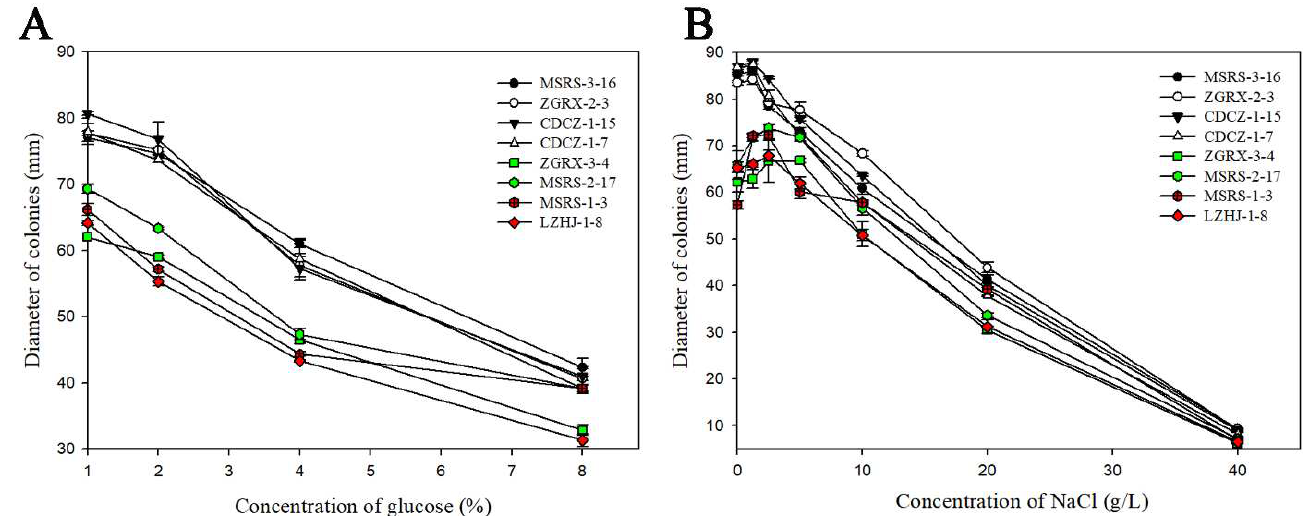
Figure 2. Fitness determination of tebuconazole-susceptible and -resistant isolates on PDA medium with different concentrations of glucose ( A ) or NaCl ( B ). Red or green indicates high or medium resistance to tebuconazole, respectively; black or white indicates tebuconazole-susceptible isolates. The F 7,23 values of the colony diameters of the different isolates on the PDA with 1% glucose, 2% glucose, 4% glucose, and 8% glucose were 114.368, 11.767, 1.072, and 32.483; the p values were = 0.000 < 0.0001, = 0.000 < 0.01, = 0.426 > 0.05, and = 0.000 < 0.01, respectively. The F 7,23 values of the colony diameters of the different isolates on the PDA with 0, 1.25, 2.5, 5, 10, 20, 40, and 80 g/L NaCl were 83.665, 110.603, 12.916, 37.355, 23.083, 36.933, and 15.752, respectively; the p values all were = 0.000 < 0.0001.